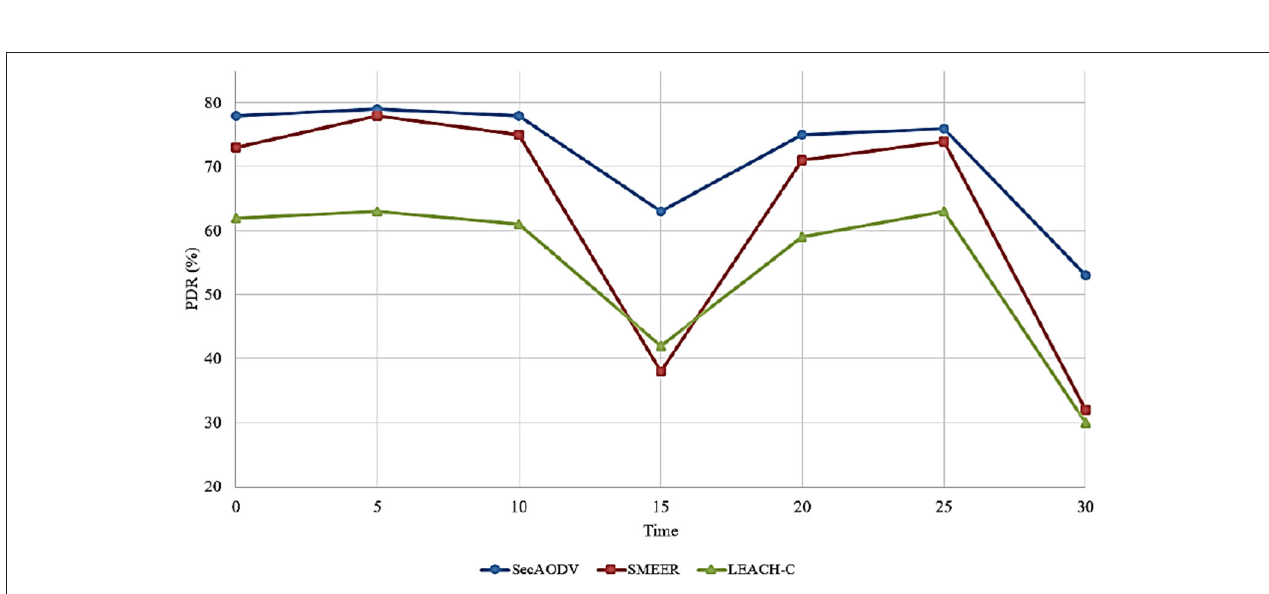
FIGURE 11 | Comparison of different methods in terms of